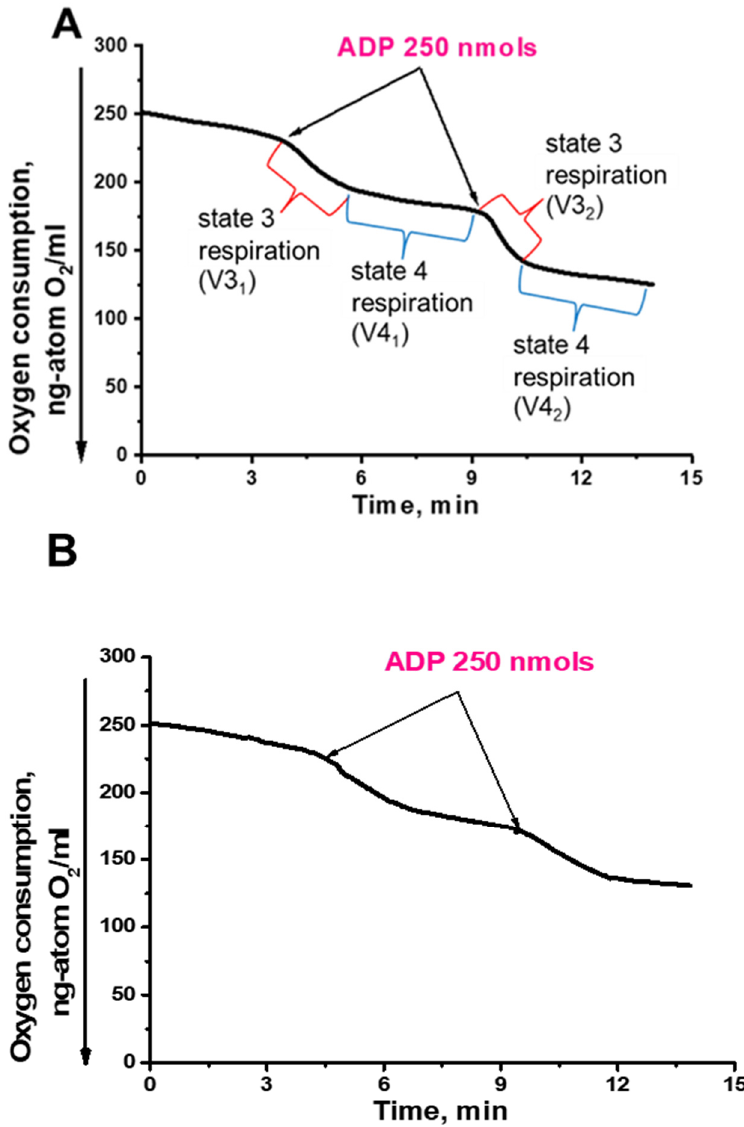
Figure 4. Amperometric recording of oxygen consumption by the isolated Y. lipolytica mitochondria. ( A ) Y. lipolytica Po1f; ( B ) Y. lipolytica Po1f pZ-A β 42. The basic incubation medium containing 0.6 M mannitol, 2 mM Tris-phosphate, pH 7.2, 1 mM EDTA was supplemented with 20 mM Tris-pyruvate + 5 mM Tris-malate and mitochondria (0.5 mg protein/mL). Where indicated, 250 nmols of ADP were added. Respiratory control ratios upon successive ADP additives were: ( A ) 4.0, 6.8; ( B ) 3.2, 3.3.